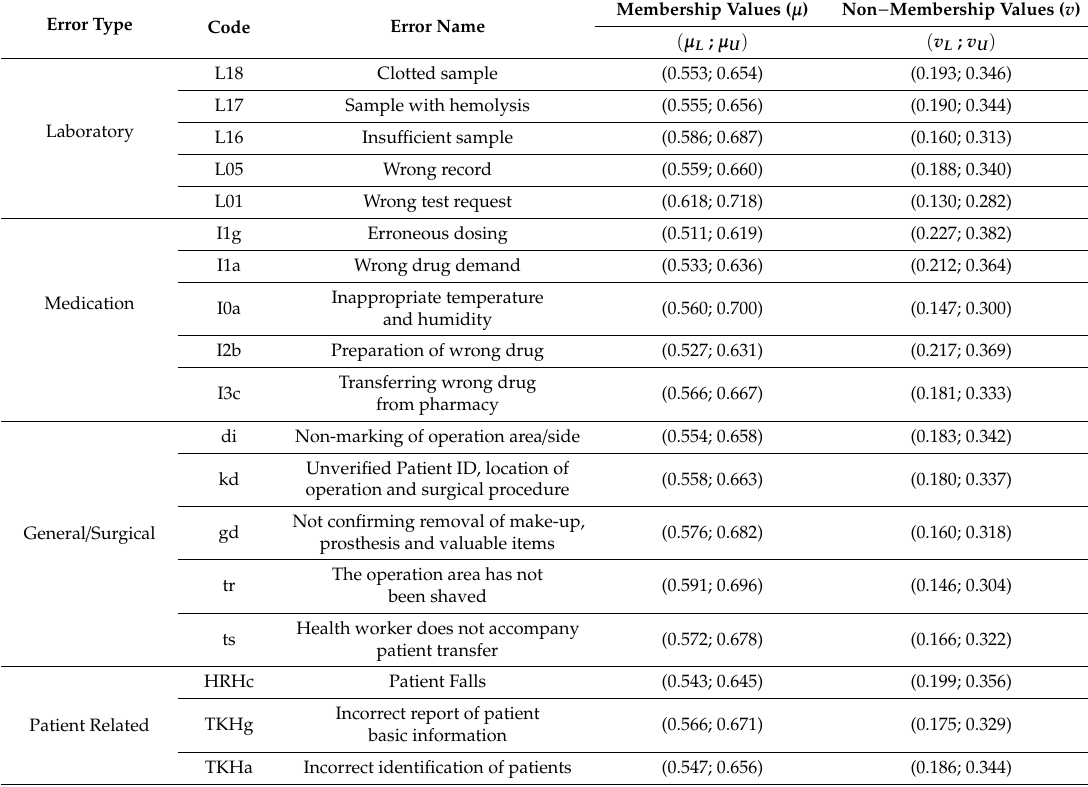
Table 8. Final Aggregated Scores for Errors in Terms of Preventability